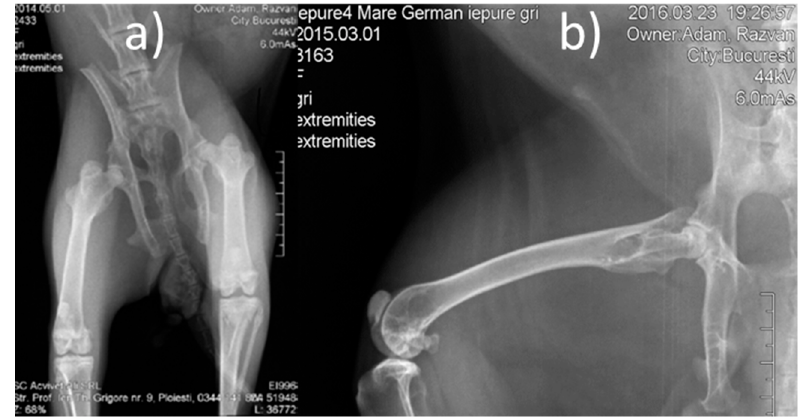
Figure 3. Pre-operative X-ray images ( a ) front view, ( b ) lateral view.